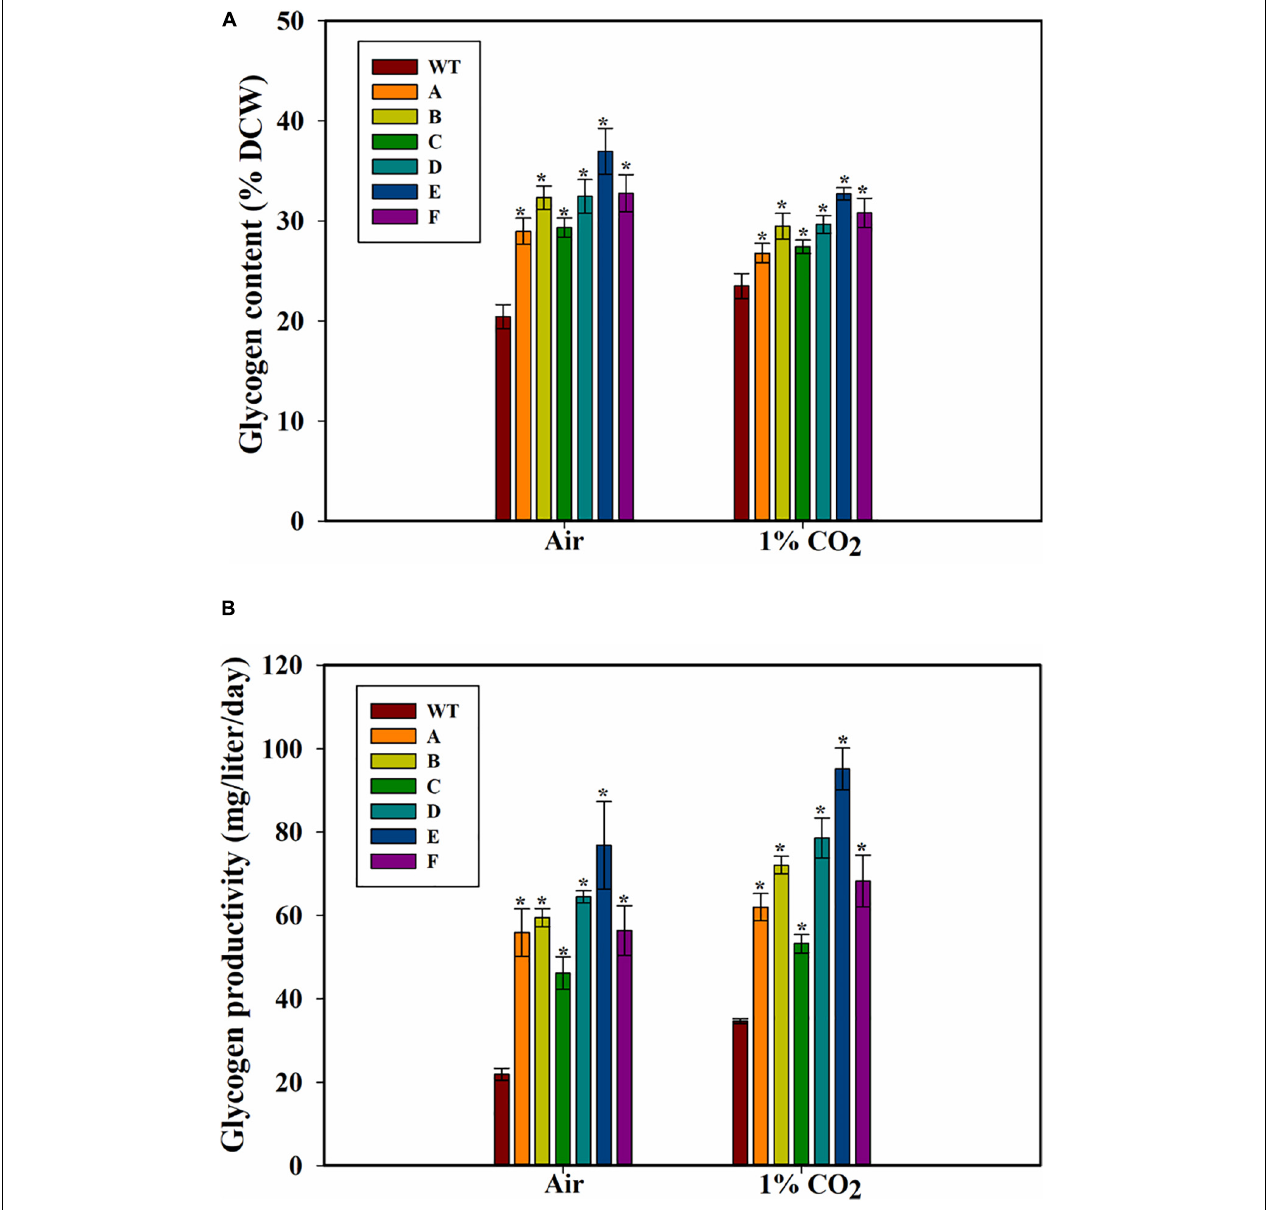
FIGURE 4 | Glycogen content and productivity of the cells. (A) Intracellular glycogen content, (B) glycogen productivity of WT PCC 7002 and transformants with bubbling of air or 1% CO 2 , measured after 5 days of growth. * p < 0.05 compared to WT PCC 7002 cells grown at the same CO 2 concentrations. n =